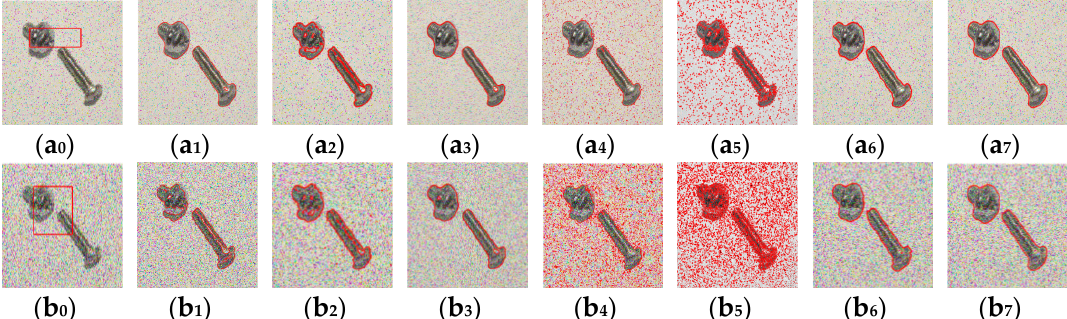
Figure 9. Image segmentation results for different pretzel noise levels: ( a 0 -b 0 ) are pretzel noise images with levels of 0.05 and 0.2, respectively. ( a 1 -b 1 ) are the results of the segmentation using the model from [16]. ( a 2 -b 2 ) are the results of the HLFRA model segmentation. ( a 3 -b 3 ) are the results of the GLFIF model segmentation. ( a 4 -b 4 ) are the results of the LBF model segmentation. ( a 5 -b 5 ) are the results of the LIF model segmentation; ( a 6 -b 6 ) are the results of the segmentation using the model from [27]. ( a 7 -b 7 ) are the results of the NFD-LIF model segmentation.